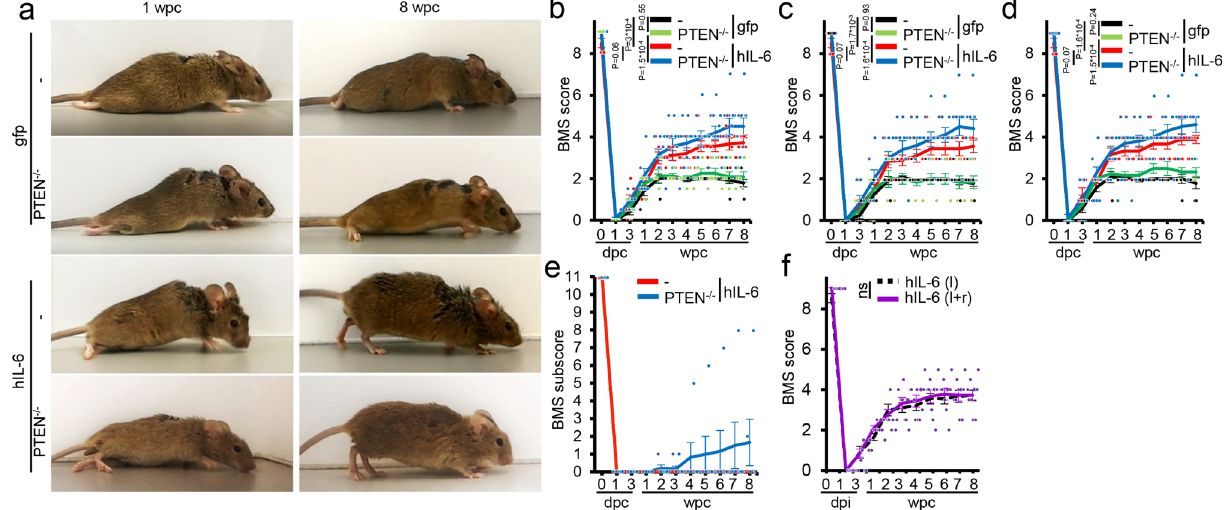
Fig. 3 Hyper-IL-6 enables functional recovery after SCC. a Representative pictures are showing open fi eld hindlimb movement of mice at 1 and 8 weeks after spinal cord crush (wpc) and treatment, as described in Fig. 2. b – d BMS score of animals as described in ( a ). Scores were evaluated at 0, 1, 3, 7 days post crush (dpc) and then weekly over 8 weeks after spinal cord injury. Values represent means± SEM of 6 – 10 animals per group (PTEN + / + /gfp, n = 7; PTEN + / + /hIL-6, n = 9; PTEN − / − /gfp, n = 6; PTEN − / − /hIL-6, n = 10), showing either the average score of the left and right hind paw ( b ) or left ( c ) and right ( d ) side separately. e BMS subscore of hIL-6 treated PTEN + / + ( − ) and PTEN − / − mice as described in ( a ). f Average BMS score of left and right hind paws from mice after SCC and bilateral (left and right hemisphere (l + r)) intracortical injection of AAV2-hIL-6 compared to animals that had received a unilateral injection into the left hemisphere (l) only as presented in ( b ). Values represent the mean ± SEM of 9 animals per group (l, n = 9; l + r, n = 9). Signi fi cances of intergroup differences were evaluated using a two-way analysis of variance (ANOVA) with a Tukey post hoc test ( b – d ) or two-sided student ’ s t- test ( f ). P -values indicate statistical signi fi cance; ns = non-signi fi cant. Source data are provided as a Source data fi le.